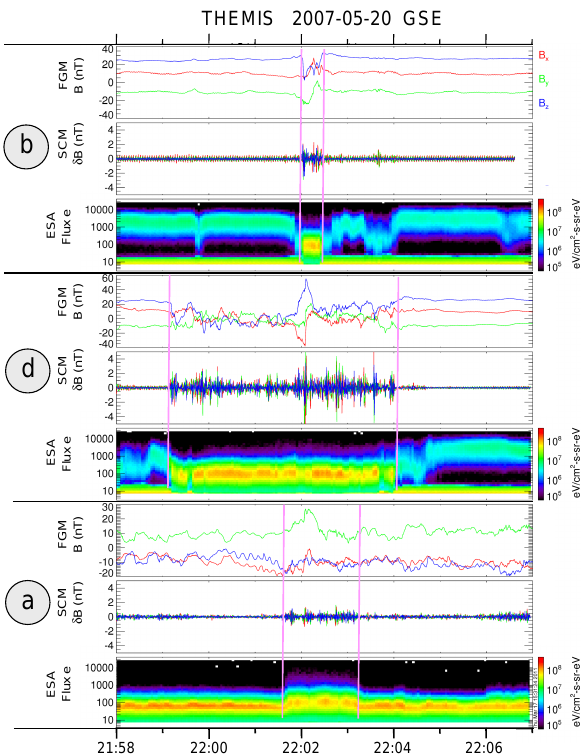
Fig. 3. Composite showing (i) the magnetic field, (ii) the ion den- sity, (iii) the ion temperature, and (iv) an ion spectrogram, for Thb, Thd, and Tha respectively. As Tha approaches the MpCL the ion temperature variation remains small (see last panels). The ion tem- peratures at Thb and Thc in the MpCL (between vertical lines) are almost the same as the ion temperature measured by Tha in the free MSh. Note that the ion density inside the bracketed regions (which corresponds to MpCL) of Thb and Thd is about the same as in the MSh